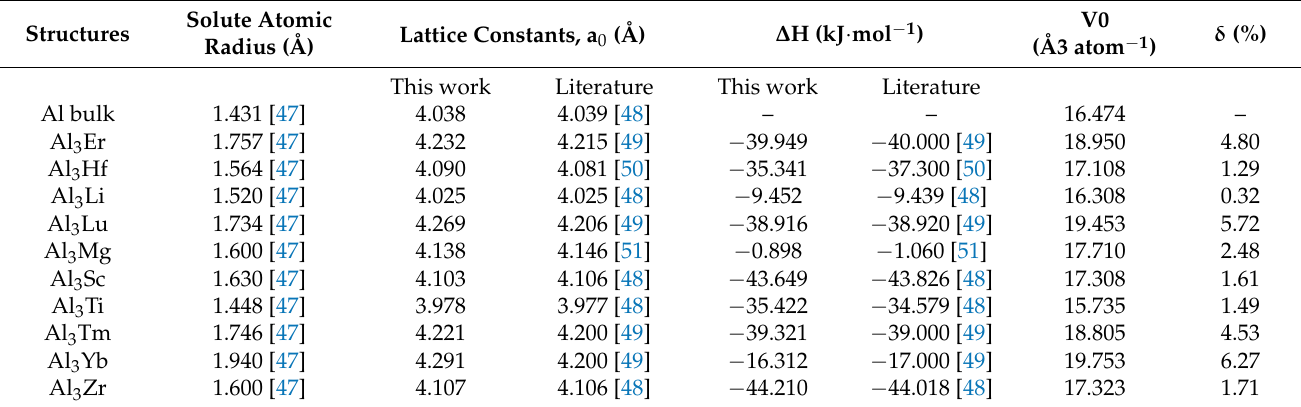
Table 1. The Solute atomic radius (Å) and calculated lattice constants, a 0 (Å), formation enthalpy, ∆ H (kJ · mol − 1 ), volume per atom, V 0 (Å 3 atom − 1 ), and lattice mismatch, δ (%), of L1 2 structures at 0 K.